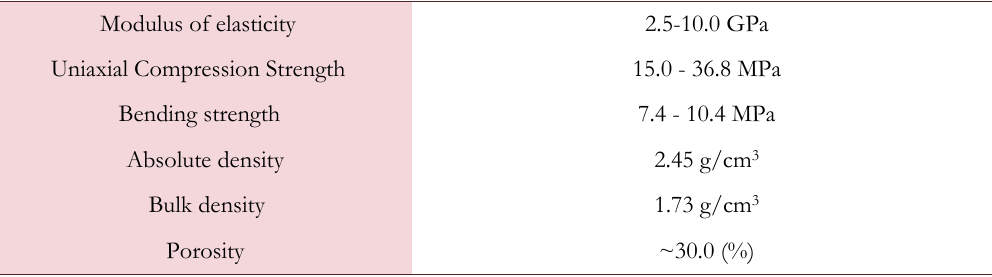
Table 1: Mechanical properties of Alfas stone [4-7] (The values strongly depend on the point and depth of